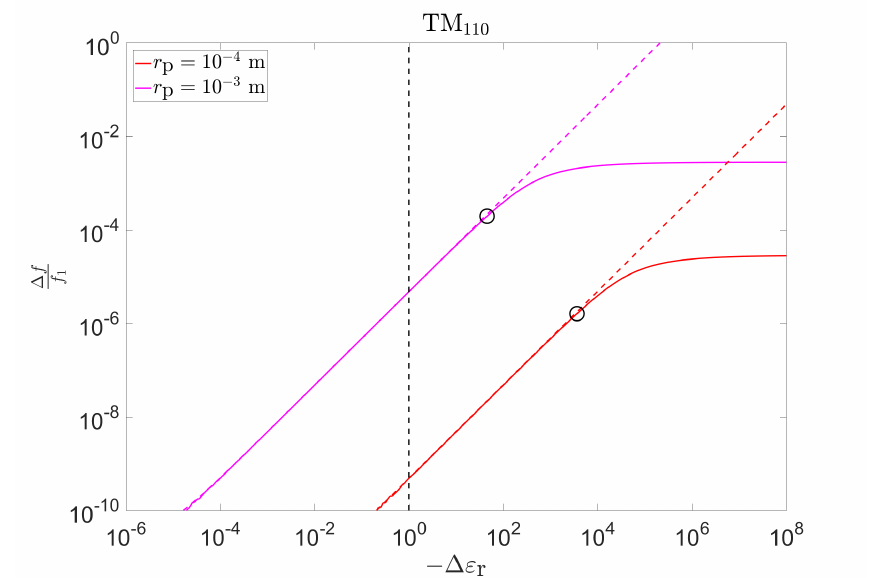
∆ f as a function of the f 1